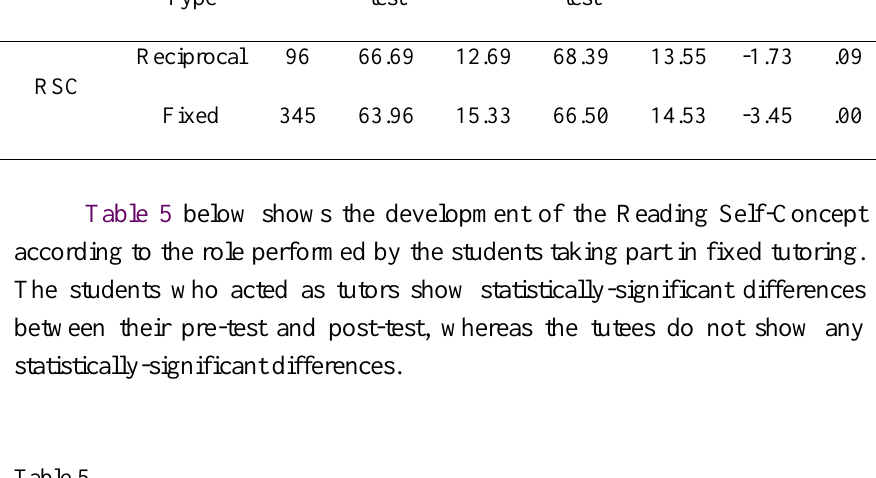
Reading Self-Concept (RSC) pre-test and post-test results in IG according to role